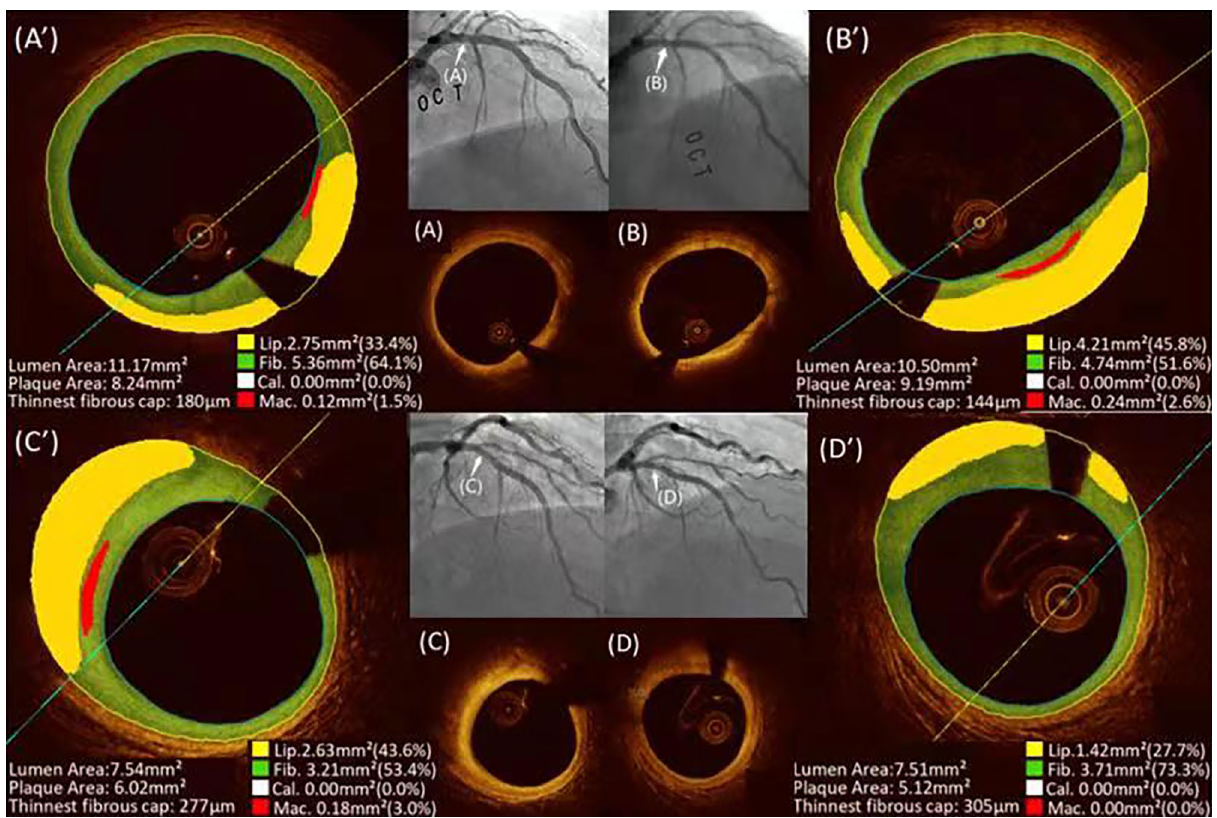
Figure 3. Typical cases of cross-sectional OCT imaging in nCSA of DM ( A , B ) and non-DM ( C , D ) at baseline and 1-year follow-up. Representative cross-sectional OCT image in DM group demonstrating increase in the lipid component from baseline (original OCT image ( A ) and OCT image by OFR analysis ( A ’) at baseline showed lipid plaque area 2.75 mm 2 and lipid plaque burden 33.4%) to 1-year follow-up (OCT image ( b ) and OCT image by OFR analysis ( B ’) showed lipid plaque area 4.21 mm 2 and lipid plaque burden 45.8%). Representative cross-sectional OCT image in DM group demonstrating reduction in the lipid component from baseline (original OCT image ( c ) and OCT image by OFR analysis ( C ’) at baseline showed lipid plaque area 2.63 mm 2 and lipid plaque burden 43.6%) to 1-year follow-up (OCT image ( d ) and OCT image by OFR analysis ( D ’) showed lipid plaque area 1.42 mm 2 and lipid plaque burden 27.7%). DM diabetes mellitus, OCT optical coherence tomography, OFR optical flow ratio.